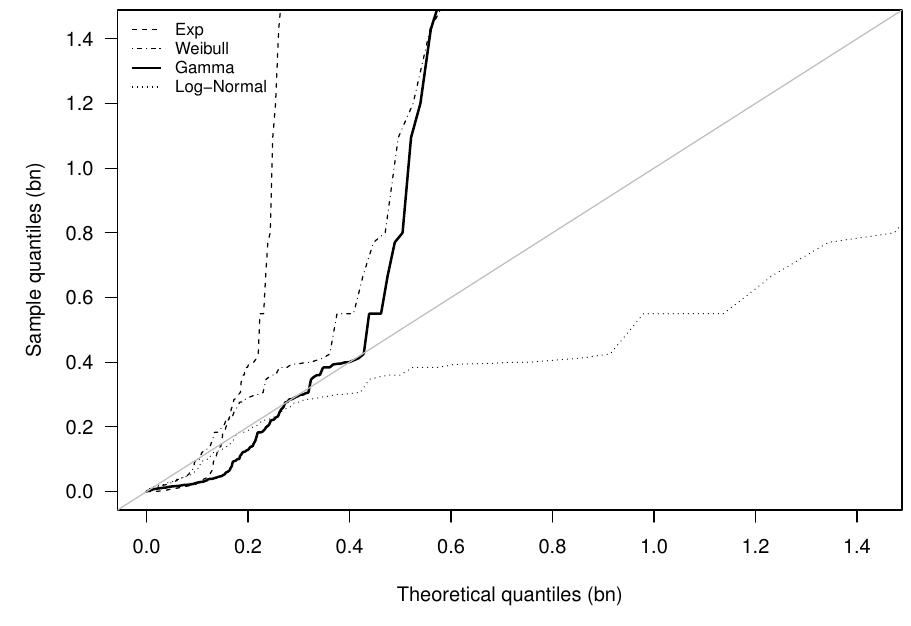
Figure A11. Fit of distribution of the equalization reserves for reinsurance